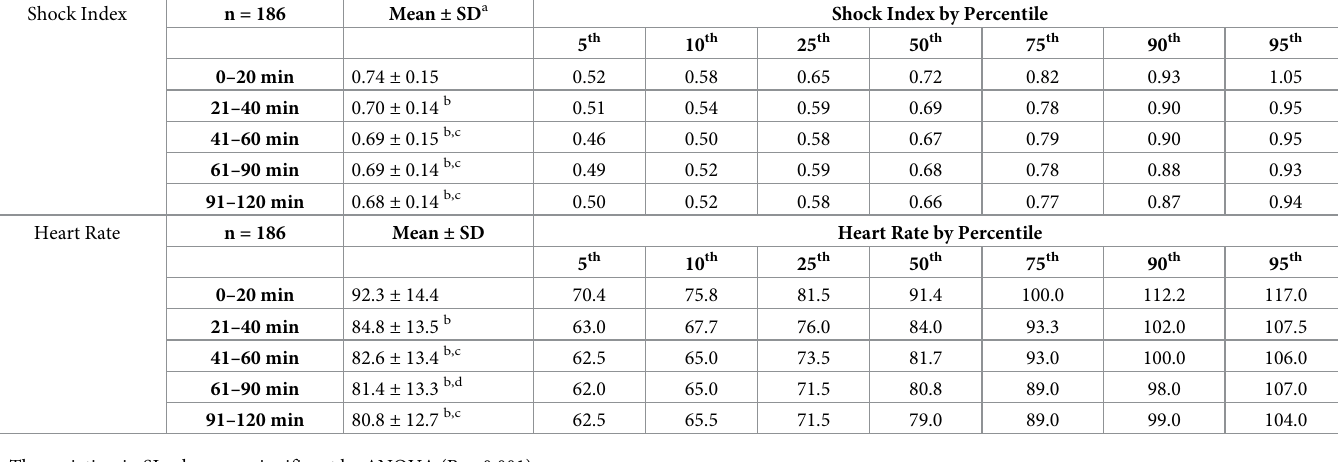
Table 2. Mean, standard deviation and percentiles of SI and HR within 2 hours after